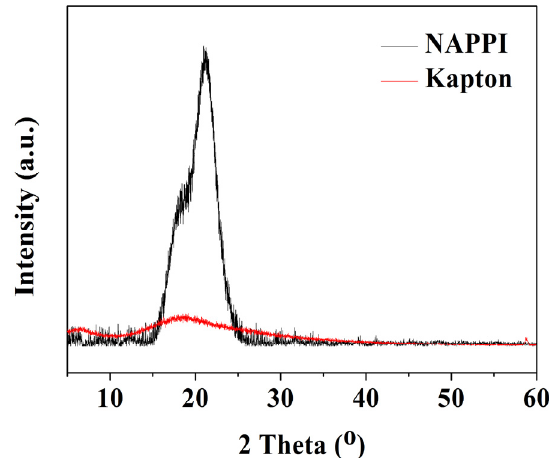
Figure 6. Wide angle X-ray diffractograms (WAXD) curves of the Kapton and NAPPI.